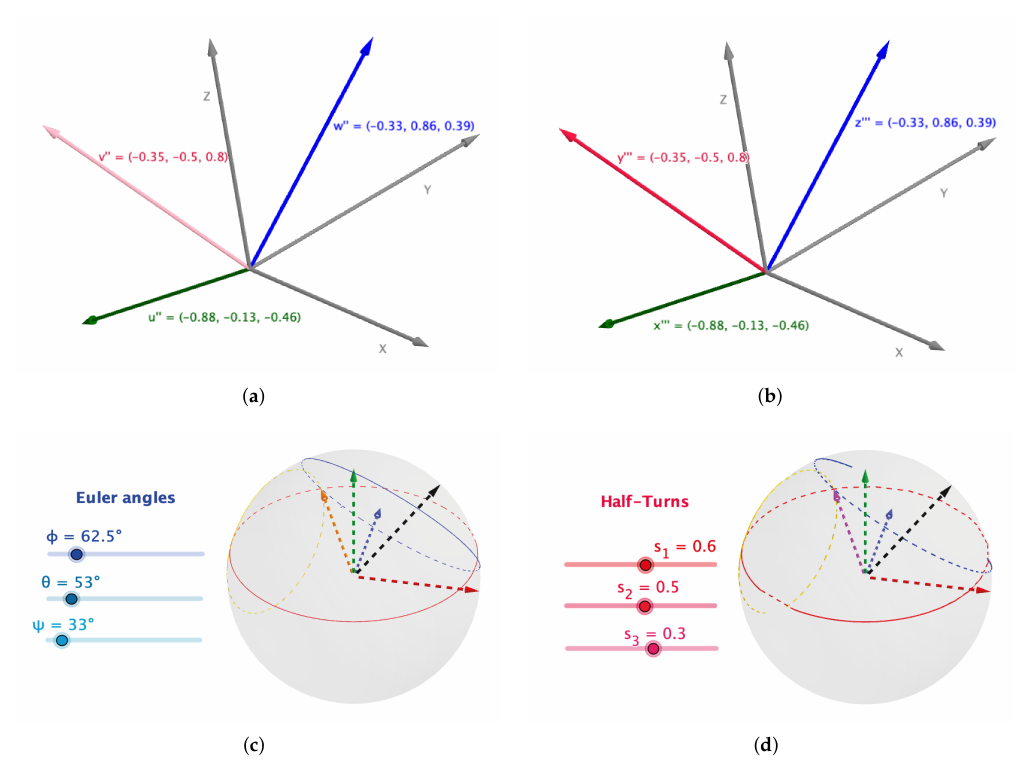
Figure 8. Simulation of different rotation techniques. ( a ) Intrinsic rotation, where rotations were performed around the body reference frame with parameters φ = 111 ◦ , θ = 67 ◦ , and ϕ = 60 ◦ . ( b ) Ex- trinsic rotation, where rotations were performed around the general reference frame with parameters φ = 60 ◦ , θ = 67 ◦ , and ϕ = 111 ◦ . ( c ) Classical rotation algorithm with three parameters given in angles. ( d ) Rational rotation algorithm with three parameters given in rational form ( half-turns